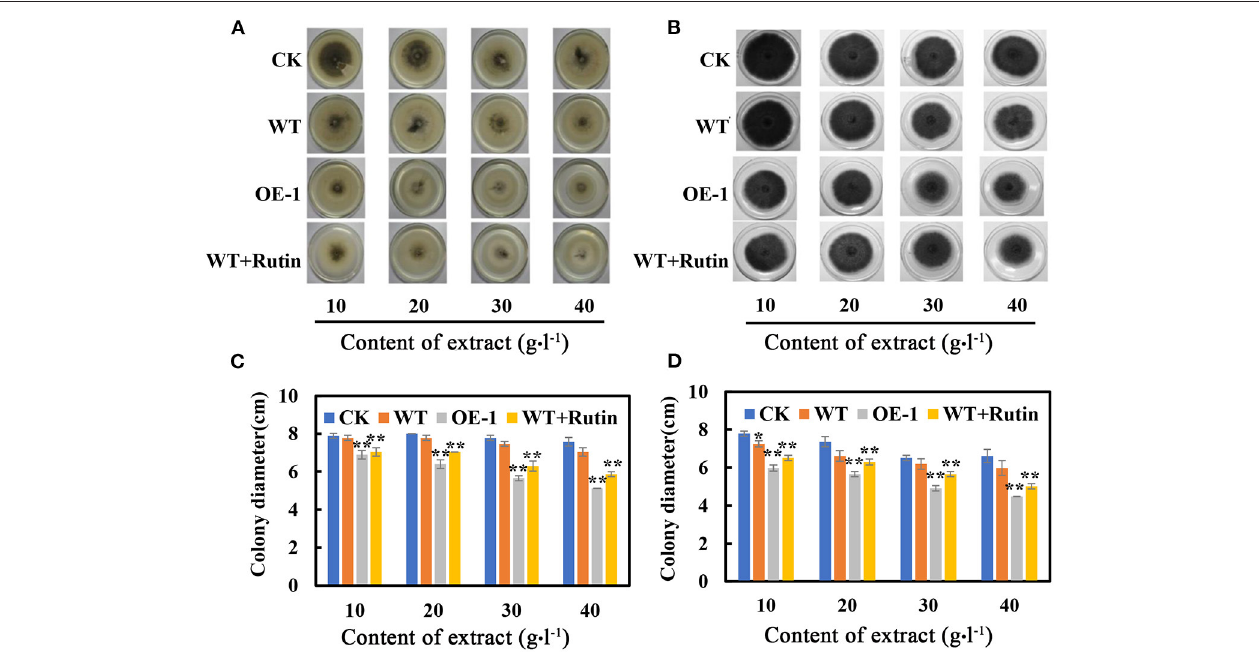
FIGURE 6 | Effect of tobacco extract on C. nicotianae Averna and A. alternata . (A) Photographs were taken after the samples were cultured for 6 days on the PDA medium with different contents of C. nicotianae Averna extract. The extracts and rutin were dissolved in dimethyl sulfoxide (DMSO). (B) Photographs of A. alternata were taken after culturing the samples for 6 days on the culture medium with different extract contents. (C) Colony diameter of C. nicotianae Averna after culturing for 6 days. (D) Colony diameters of A. alternata after culturing for 6 days. CK, PDA plus DMSO. WT, PDA with the extract of wild-type tobacco leaves. OE-1, PDA with the extract of transgenic tobacco leaves. WT + rutin, PDA with the extract of wild-type tobacco leaves and rutin corresponding to transgenic leaf extracts. The values are the means ± SD ( n = 5, * p < 0.05, ** p < 0.01).